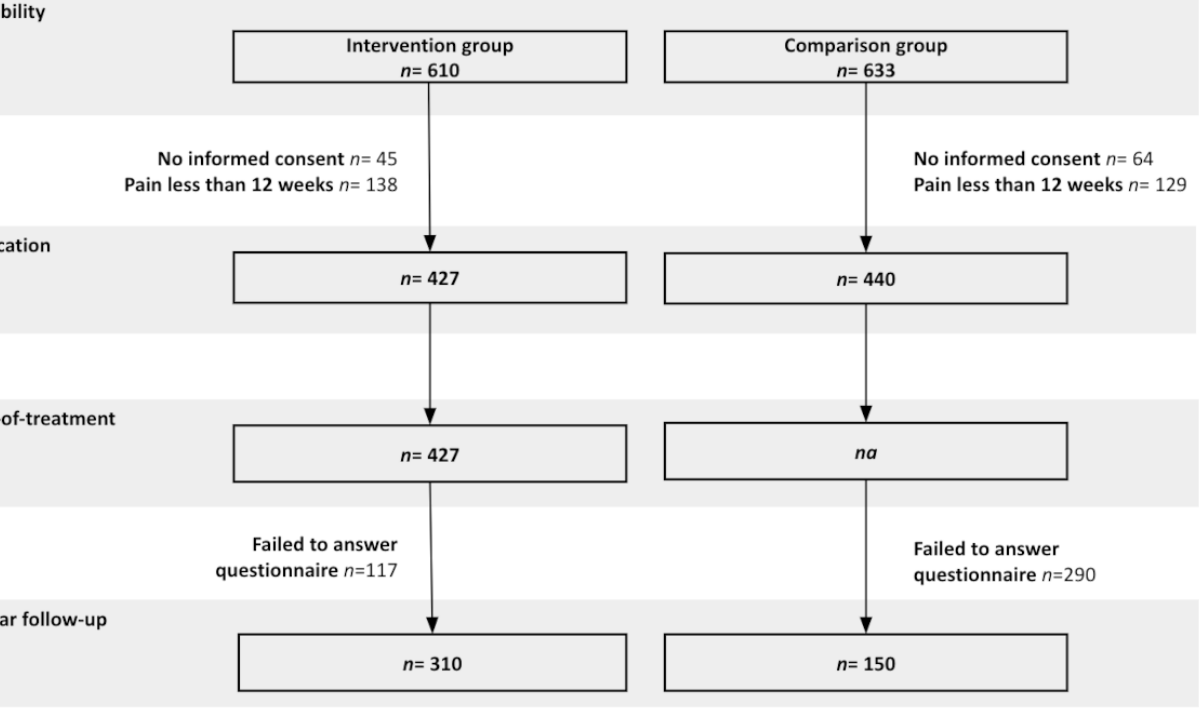
Table 1. Baseline characteristics of study sample and considering intervention and comparison group. Statistical analysis was performed between the intervention and comparison group.